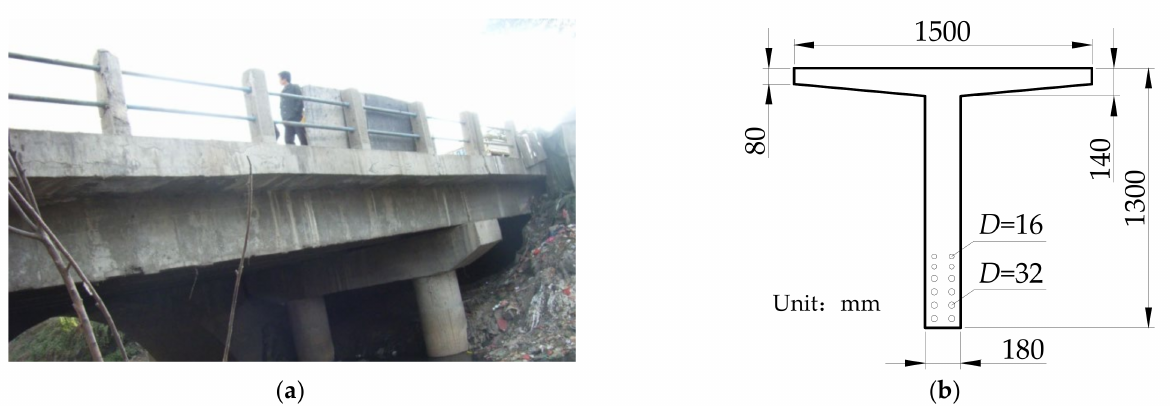
Figure 3. Appearance of typical simply supported T-beam bridge: ( a ) profile of Xiaobai Bridge; ( b ) cross-sectional dimension drawing of T-beam.